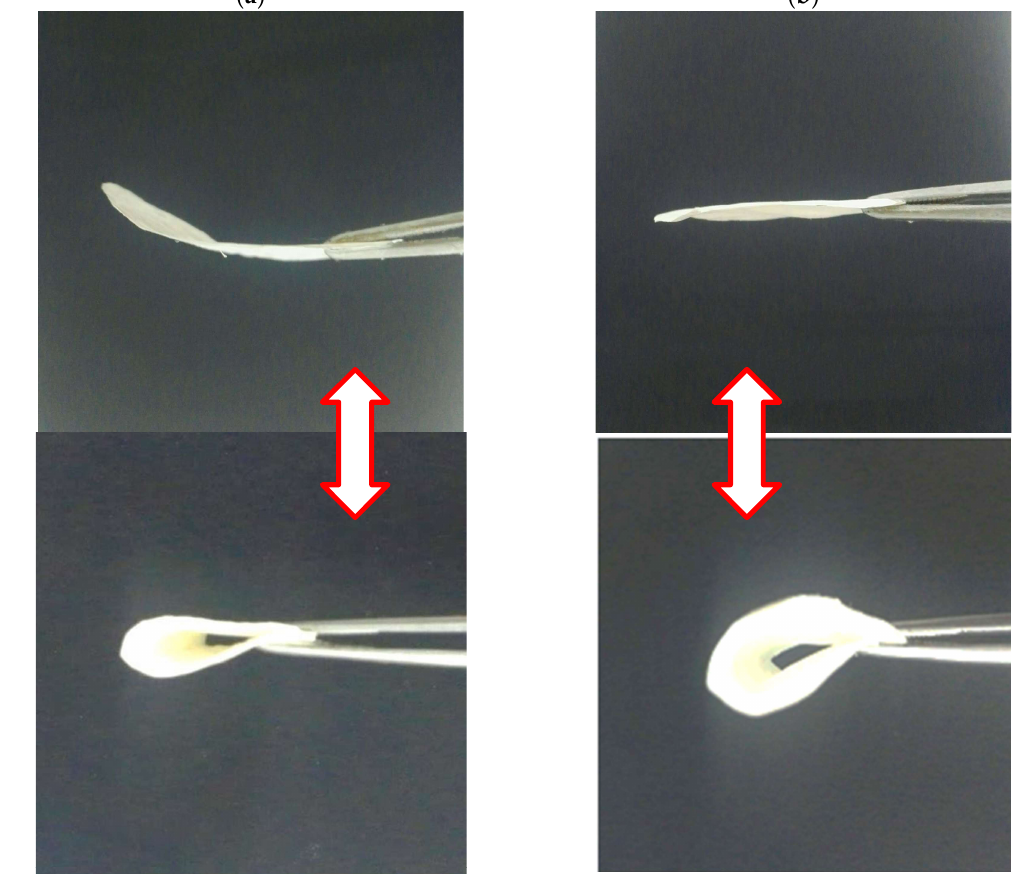
Figure 10. Flexibility analysis of Pure BC film ( a ) and as-prepared BC/CA-ENM hybrid mat ( b ) samples.